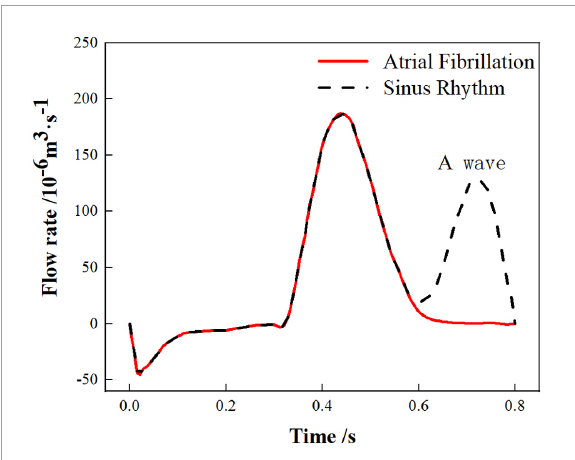
FIGURE2 The variations in mitral flow within a single cardiac cycle.